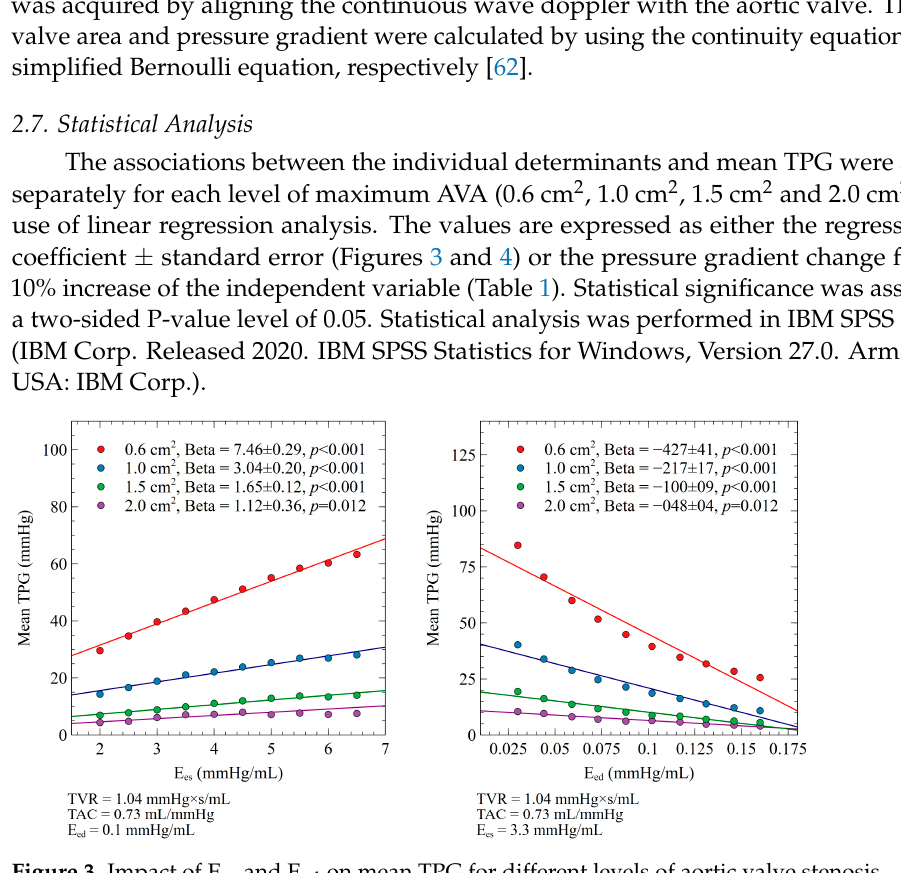
Figure 3. Impact of E es and E ed on mean TPG for different levels of aortic valve stenosis.